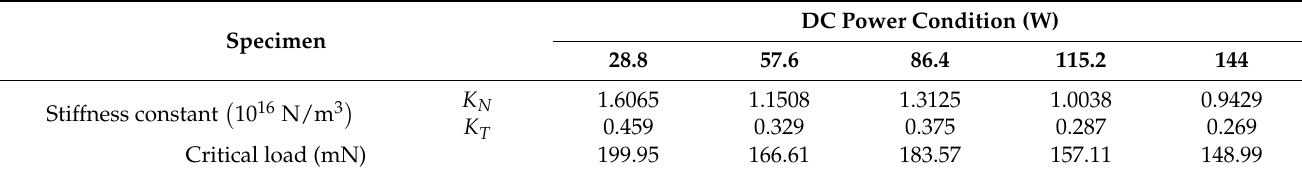
Table 4. The compared result to the stiffness constants and the critical